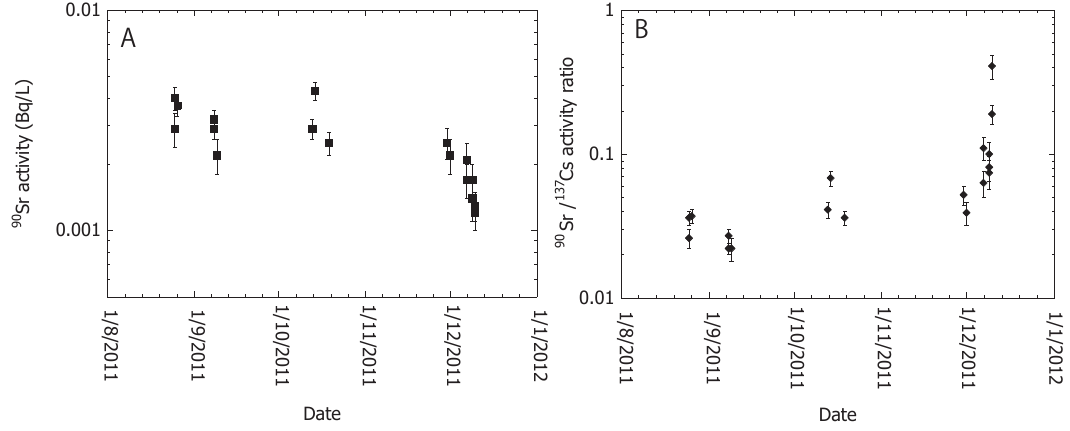
Fig. 8. Temporal variation of activities of 90 Sr in the surface water samples (A) and temporal variation of activity ratios of 90 Sr to 137 Cs in the same surface water samples (B)